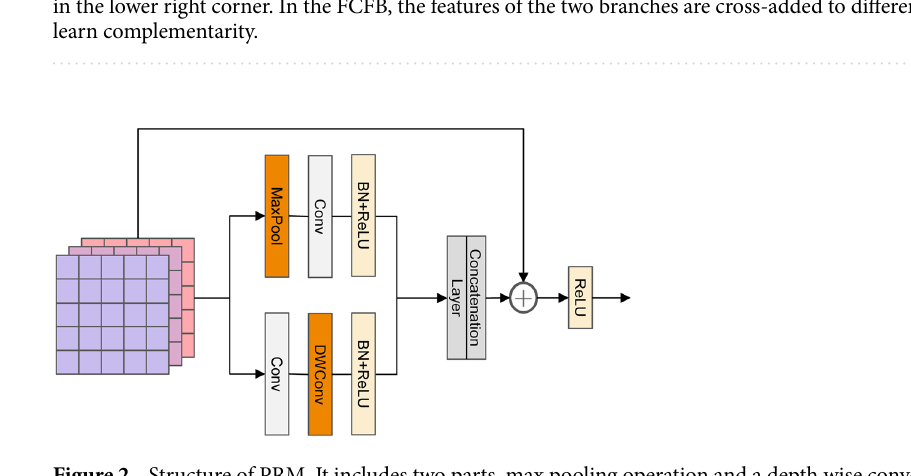
Figure 2. Structure of PRM. It includes two parts, max pooling operation and a depth wise convolutional layer. The role of PRM is to enhance the capture of local information, and the residual structure can retain more semantic information.